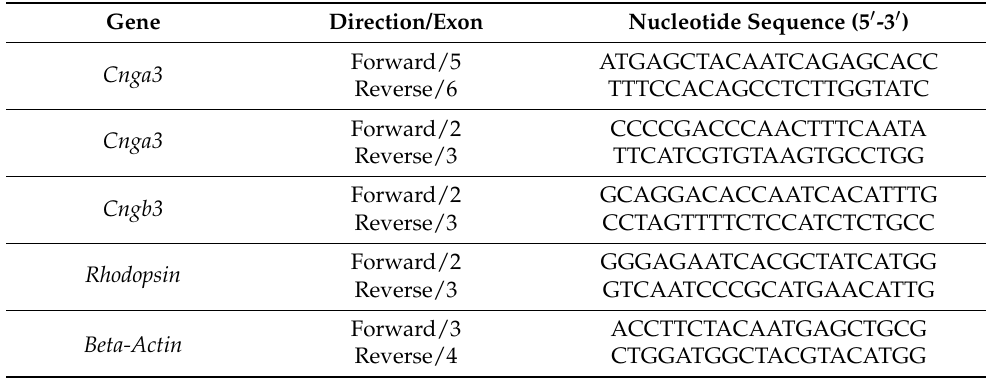
Table 3. Primers used in the transcriptome